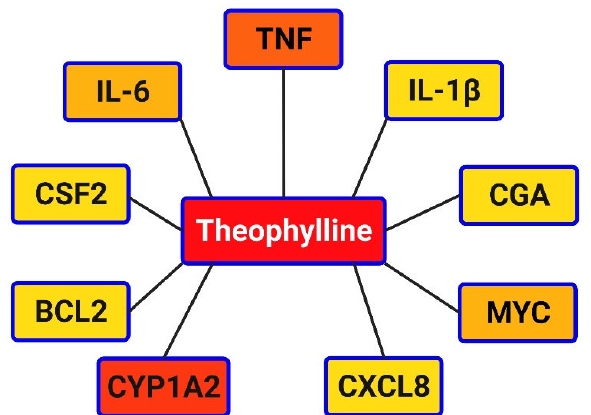
Figure 2. Pharmacological network biology analysis of theophylline ‐ genes interaction. Node in yel ‐ low represents theophylline and white nodes represent genes that are modified to different degrees: somehow affected (blue), increased (red) or decreased activity (green) according to the Comparative Toxicogenomics Database [45].